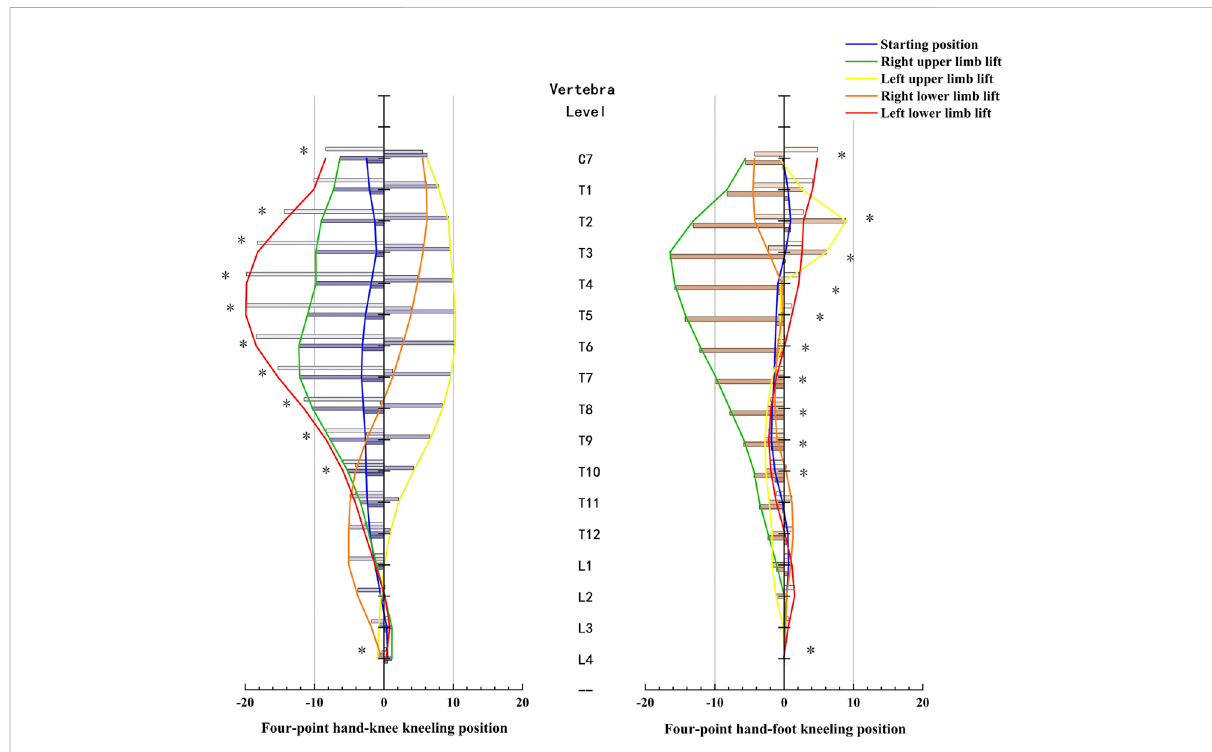
FIGURE 7 Vertebra rotation and results of one-way ANOVA during the four-point hand − knee kneeling positions and four-point hand − foot kneeling positions, respectively. *: statistically signi fi cant, p <